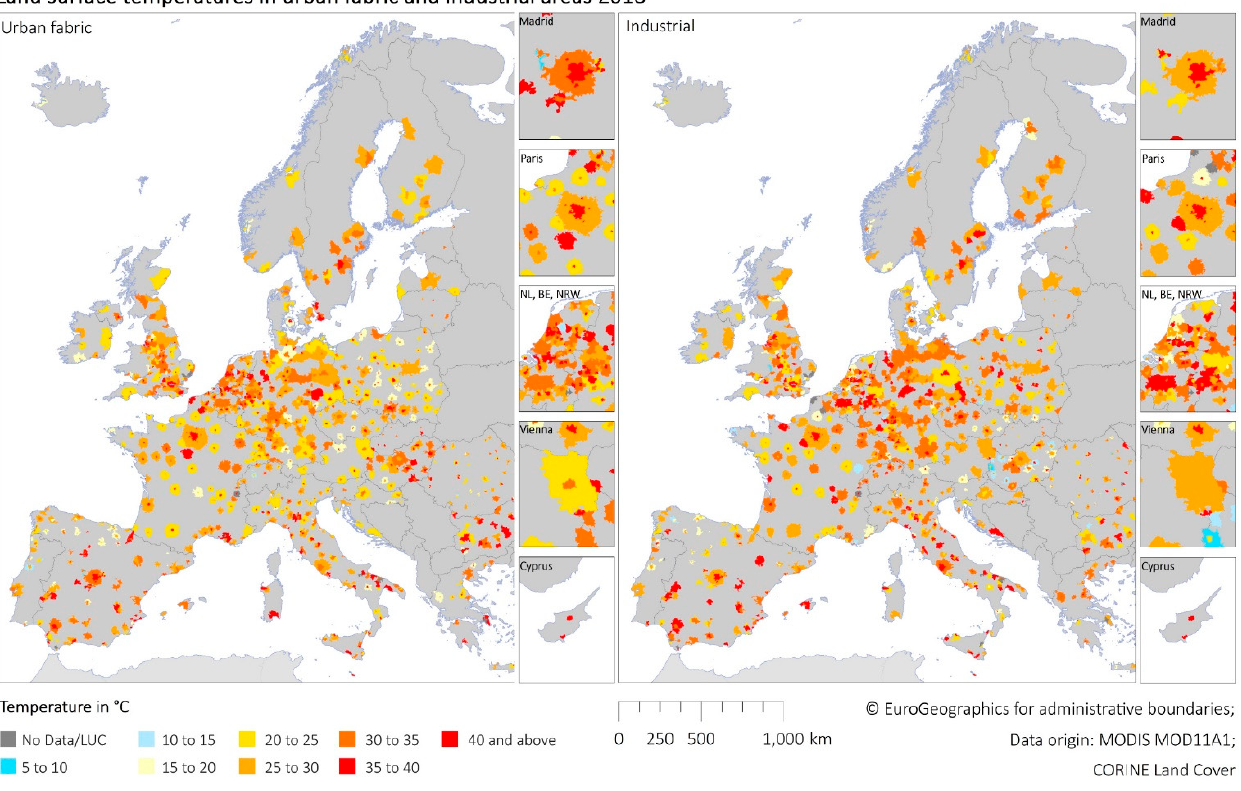
Figure 12. LST of urban fabric and industrial areas, 2018.